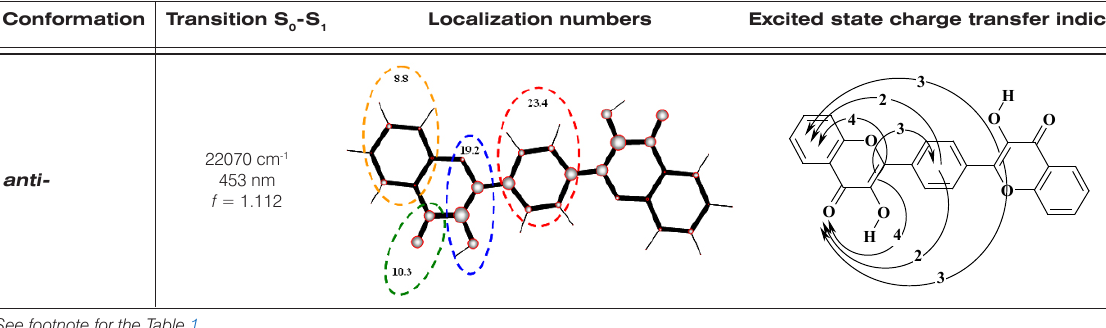
state optimized 1